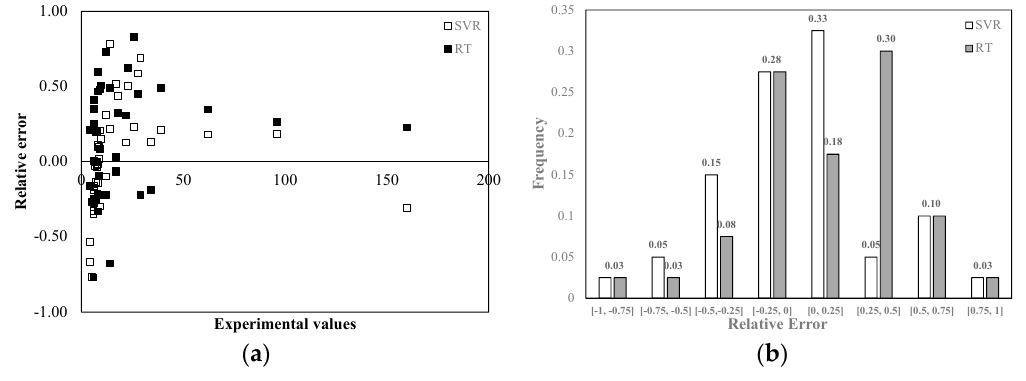
Figure 8. Distribution of errors in the BOD 5 predictions. ( a ) Relative error versus experimental values; ( b ) Frequency distribution.